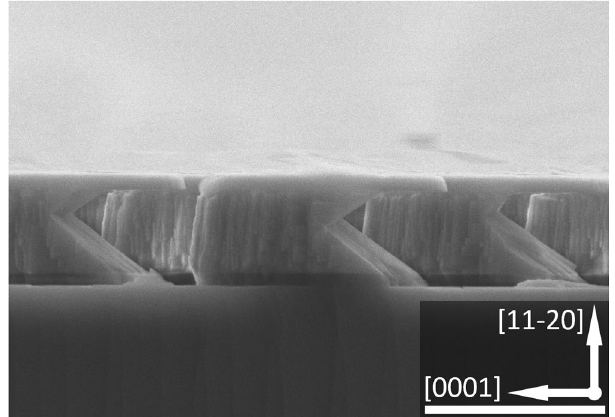
Figure 2. Cross-sectional SEM image of our micro-rod with a “mushroom” configuration. Scale bar: 2 μ